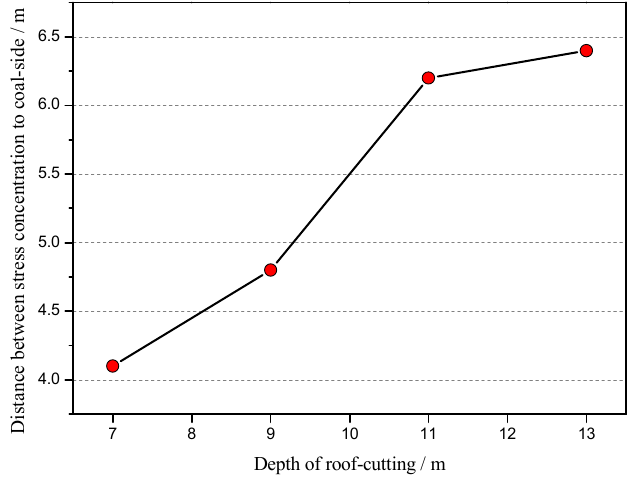
Figure 10. Relationship between depth of roof-cutting and stress concentration position.